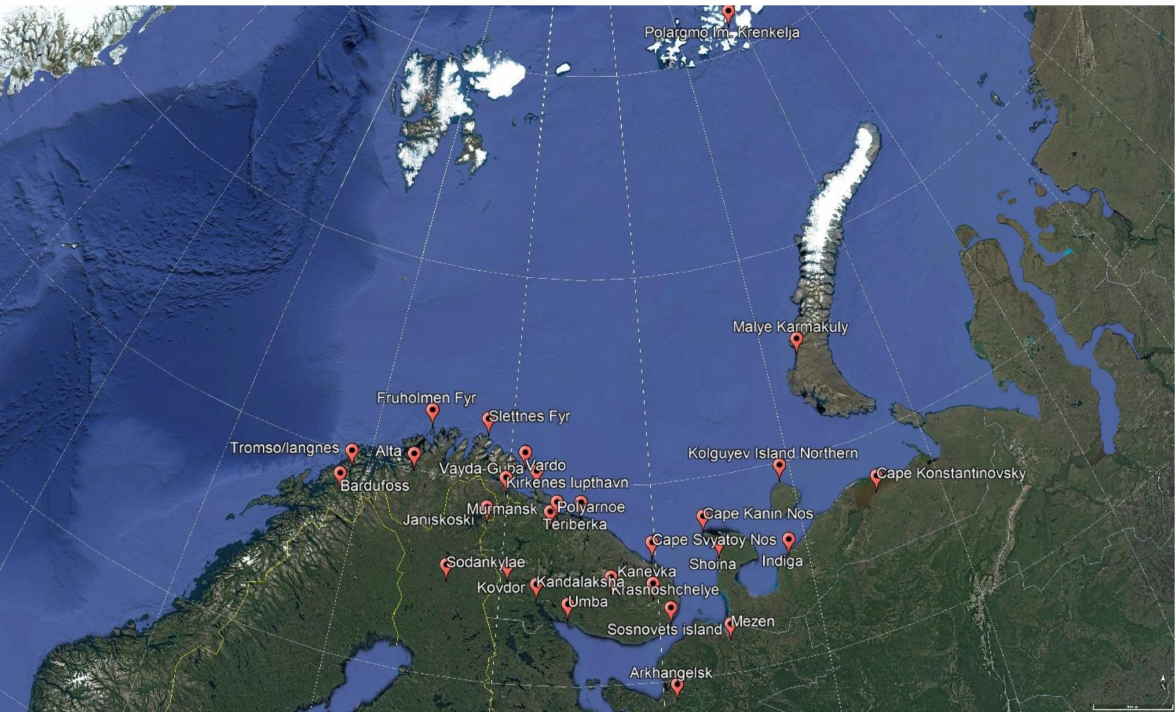
Figure 1. The area of interest and locations of observation